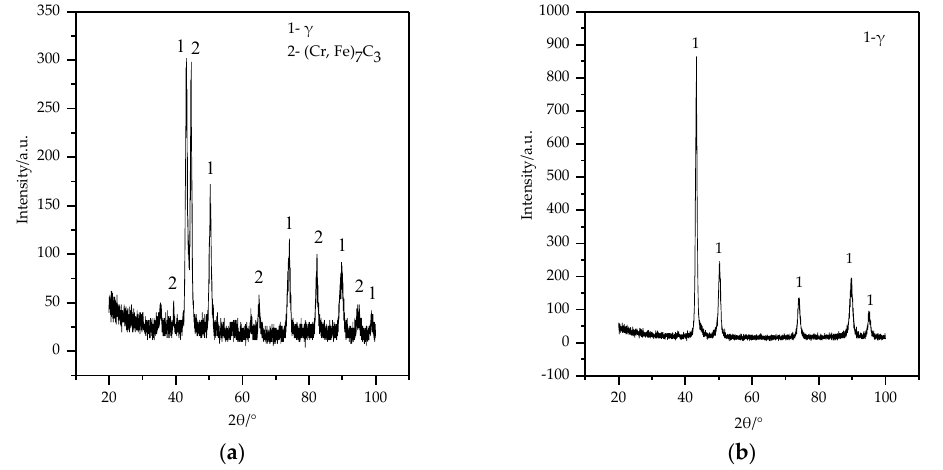
Figure 6. XRD patterns: ( a ) The over-lapped cladding layer; ( b ) The substrate.